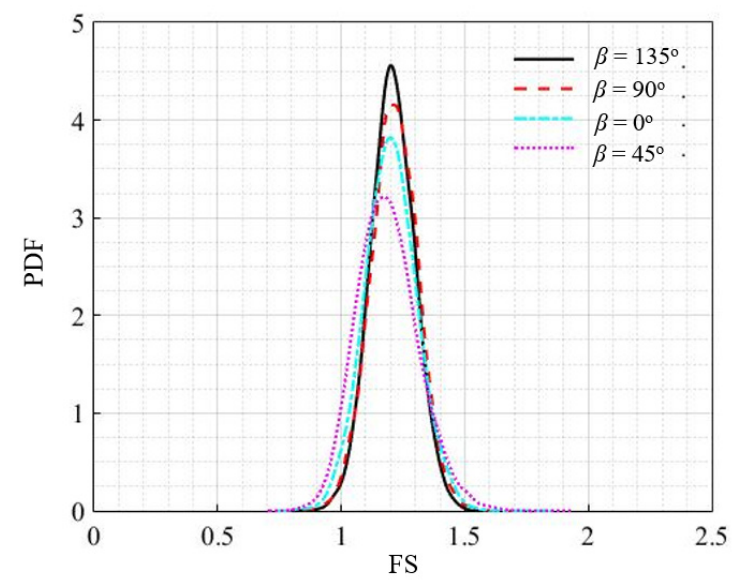
Figure 13. PDFs for different random field rotation angles.